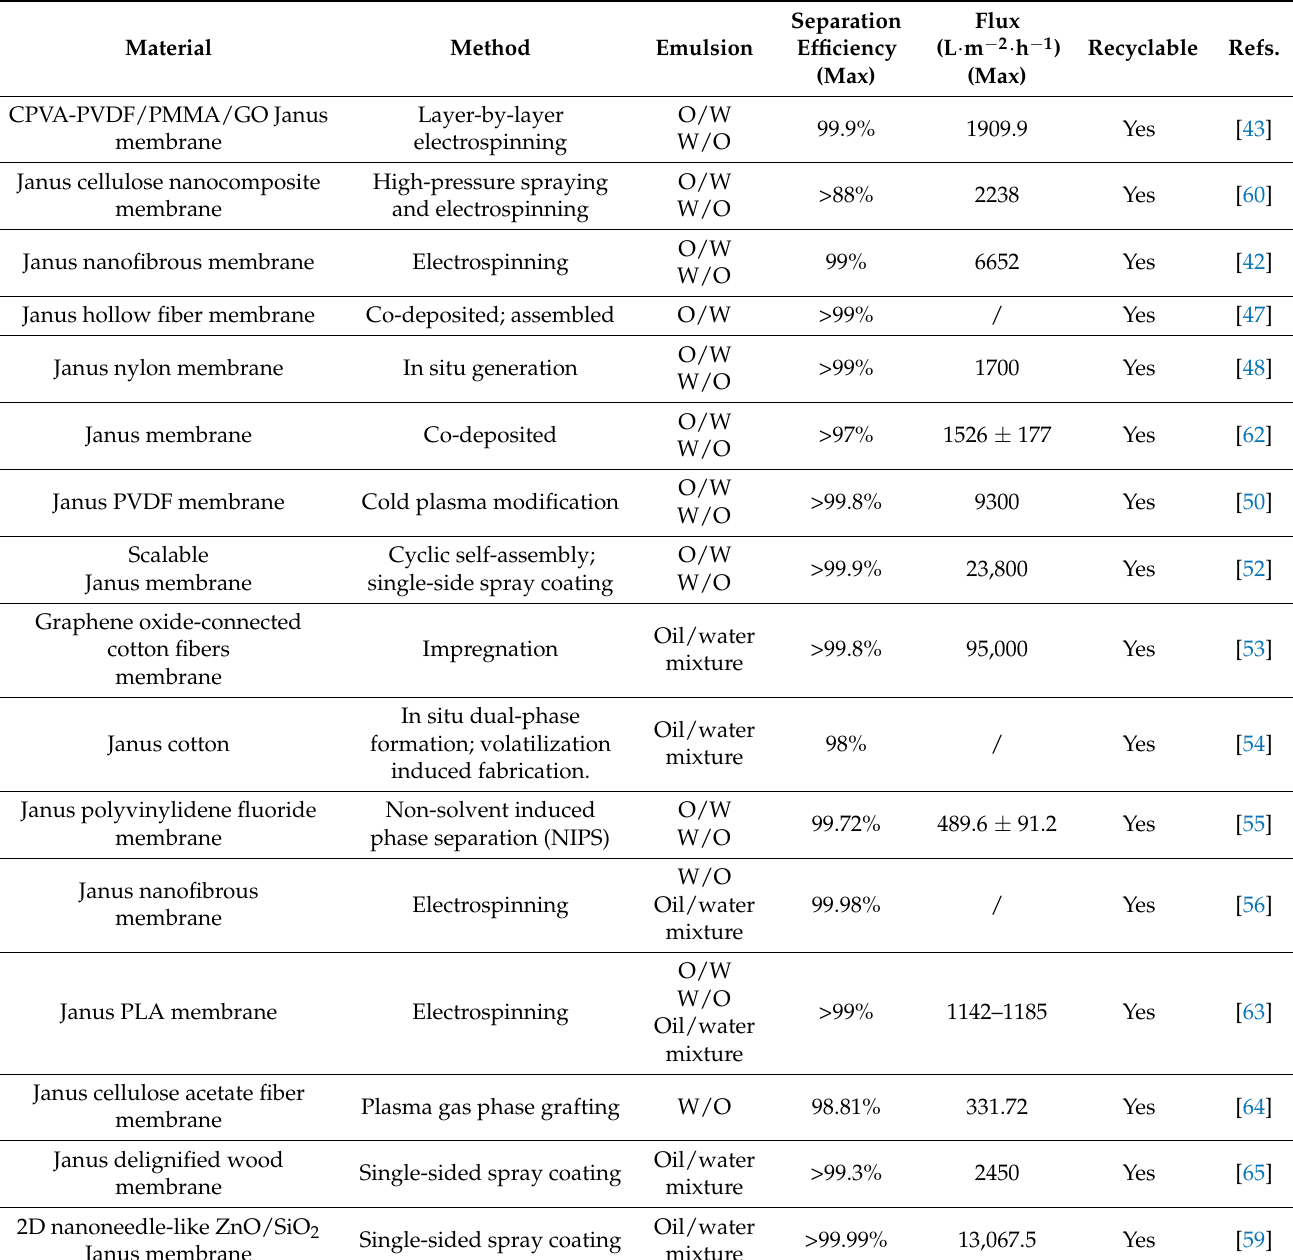
Table 2. Summary of 2D Janus materials with asymmetric wettability for oil–water